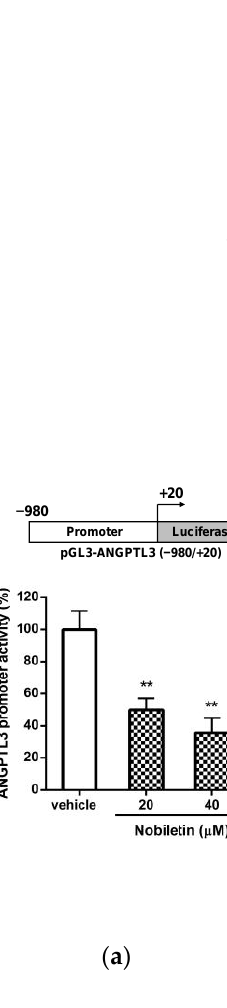
Figure 4. Effects of nobiletin on ANGPTL3 promoter activity. ( a ) HepG2 cells were co-transfected with the pGL3-ANGPTL3 ( − 980/+20) plasmid and Renilla control plasmid. After 24 h of transfection, the cells were treated with vehicle or nobiletin (20 and 40 µ M) for 24 h. Luciferase activity was determined with a reporter assay kit. Data were normalized to Renilla control luciferase activity and represent the mean ± SD from three independent experiments. ** p < 0.01 indicates a statistically significant difference compared to the vehicle-treated group. ( b ) HepG2 cells were cotransfected with serially deleted ANGPTL3 promoter–luciferase reporter plasmids, including pGL3-ANGPTL3 ( − 750/+20), pGL3-ANGPTL3 ( − 500/+20), pGL3-ANGPTL3 ( − 250/+20), and pGL3-ANGPTL3 ( − 120/+20), and a control Renilla plasmid followed by treatment with vehicle or nobiletin (40 µ M) for 24 h. Data represent the mean ± SD of three independent experiments. ** p < 0.01 indicates a significant difference compared to vehicle-treated pGL3-ANGPTL3 ( − 980/+20)-transfected cells. ## p < 0.01 indicates a significant difference compared to vehicle treatment of the respective deletion construct-transfected groups. “ns” indica tes no significance.